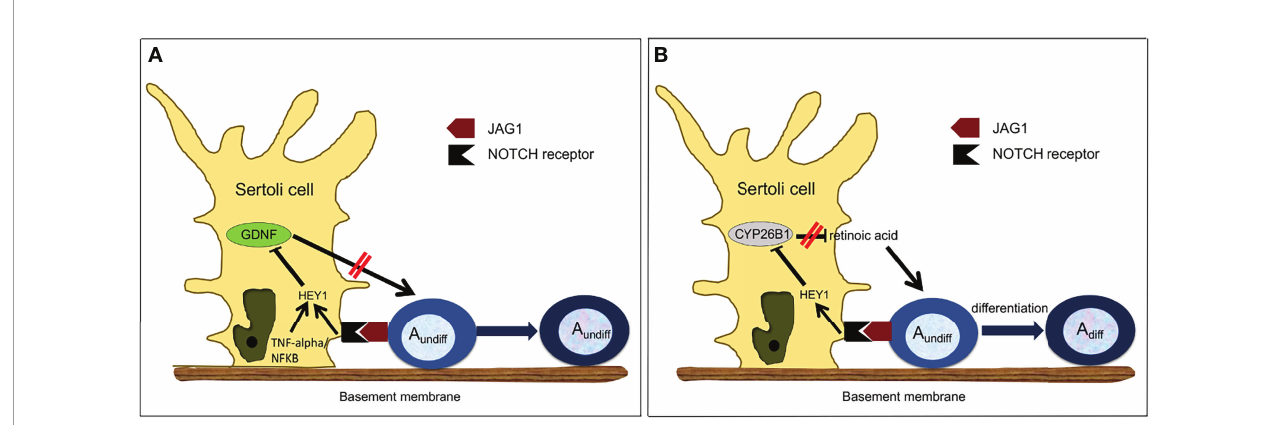
FIGURE 2 | Proposed Model of Regulation of Germ Cell Homeostasis by NOTCH Signaling. (A) Regulation of GDNF expression in Sertoli cells. GDNF is produced by Sertoli cells and normally increases Asingle, Apaired and some Aligned spermatogonia proliferation. However, as the number of undifferentiated spermatogonia increases, more JAG1 ligand is available to activate NOTCH signaling in Sertoli cells. Activated NOTCH will down-regulate the expression of GDNF through HES/ HEY, which will decrease the number of undifferentiated spermatogonia, re-establishing GDNF production. Inhibition of GDNF by HES/HEY can be potentiated by the TNF-alpha/NF-KappaB pathway. (B) Regulation of CYP26B1 expression in Sertoli cells. CYP2681 is produced by Sertoli cells and normally degrades retinoic acid. However, as the number of undifferentiated spermatogonia increases, in particular Aaligned spermatogonia, more JAG1 ligand is available to activate NOTCH signaling in Sertoli cells. Activated NOTCH will down-regulate the expression of CYP26B1, which a llows retinoic acid to trigger the transition from undifferentiated to differentiating